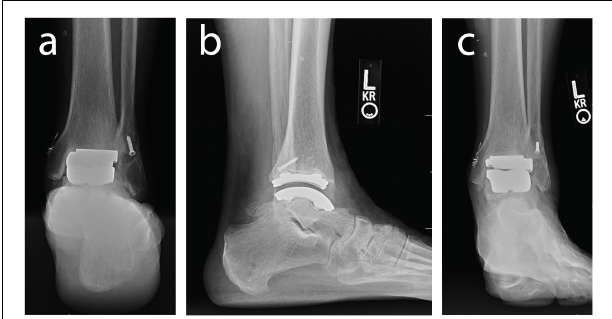
FIGURE 1 | Weight bearing radiographs of the ankle and hindfoot with an implanted left TAR including: (a) hindfoot alignment view, (b) lateral view of the ankle, and (c) anterior-posterior